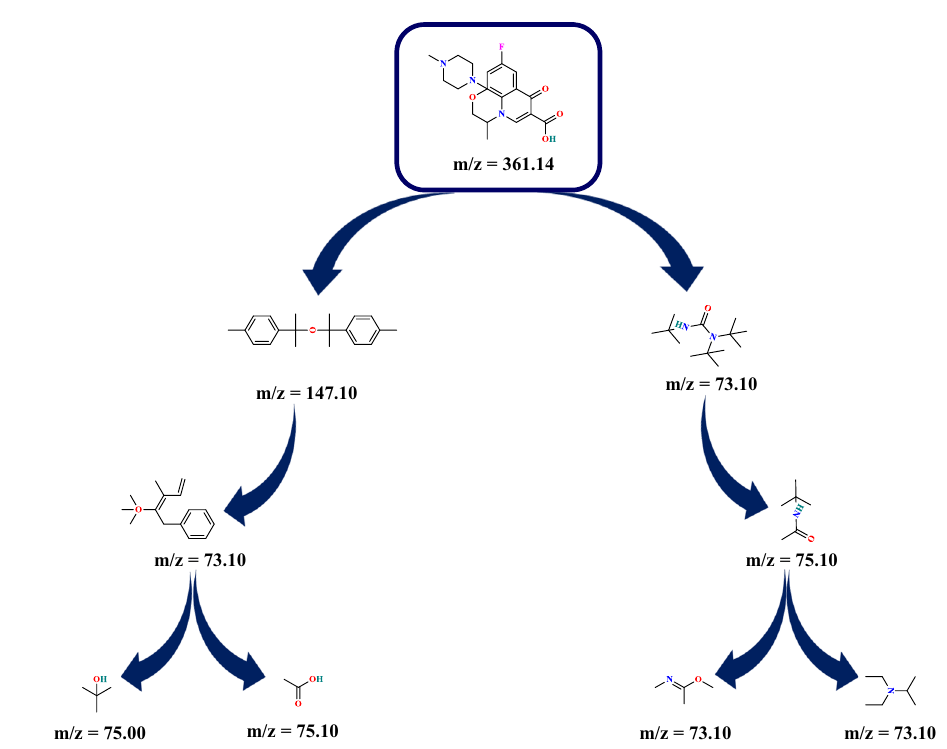
Fig. 8 Degradation mechanism of OFL. Proposed reaction pathways for OFL based on the determined